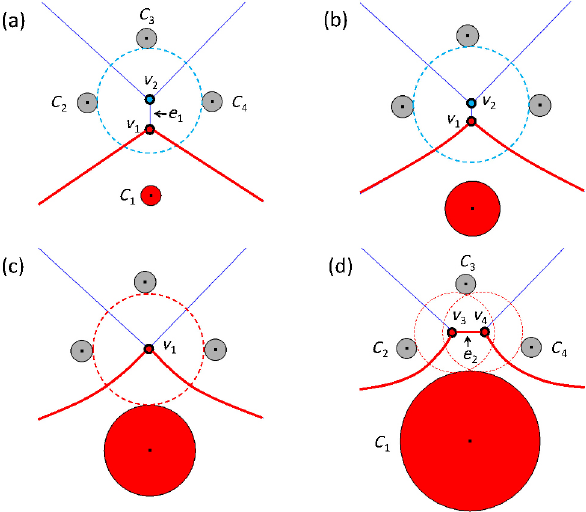
Fig. 16 During the cell-expansion process, a cell vertex vanishes when its radiating edge extends to